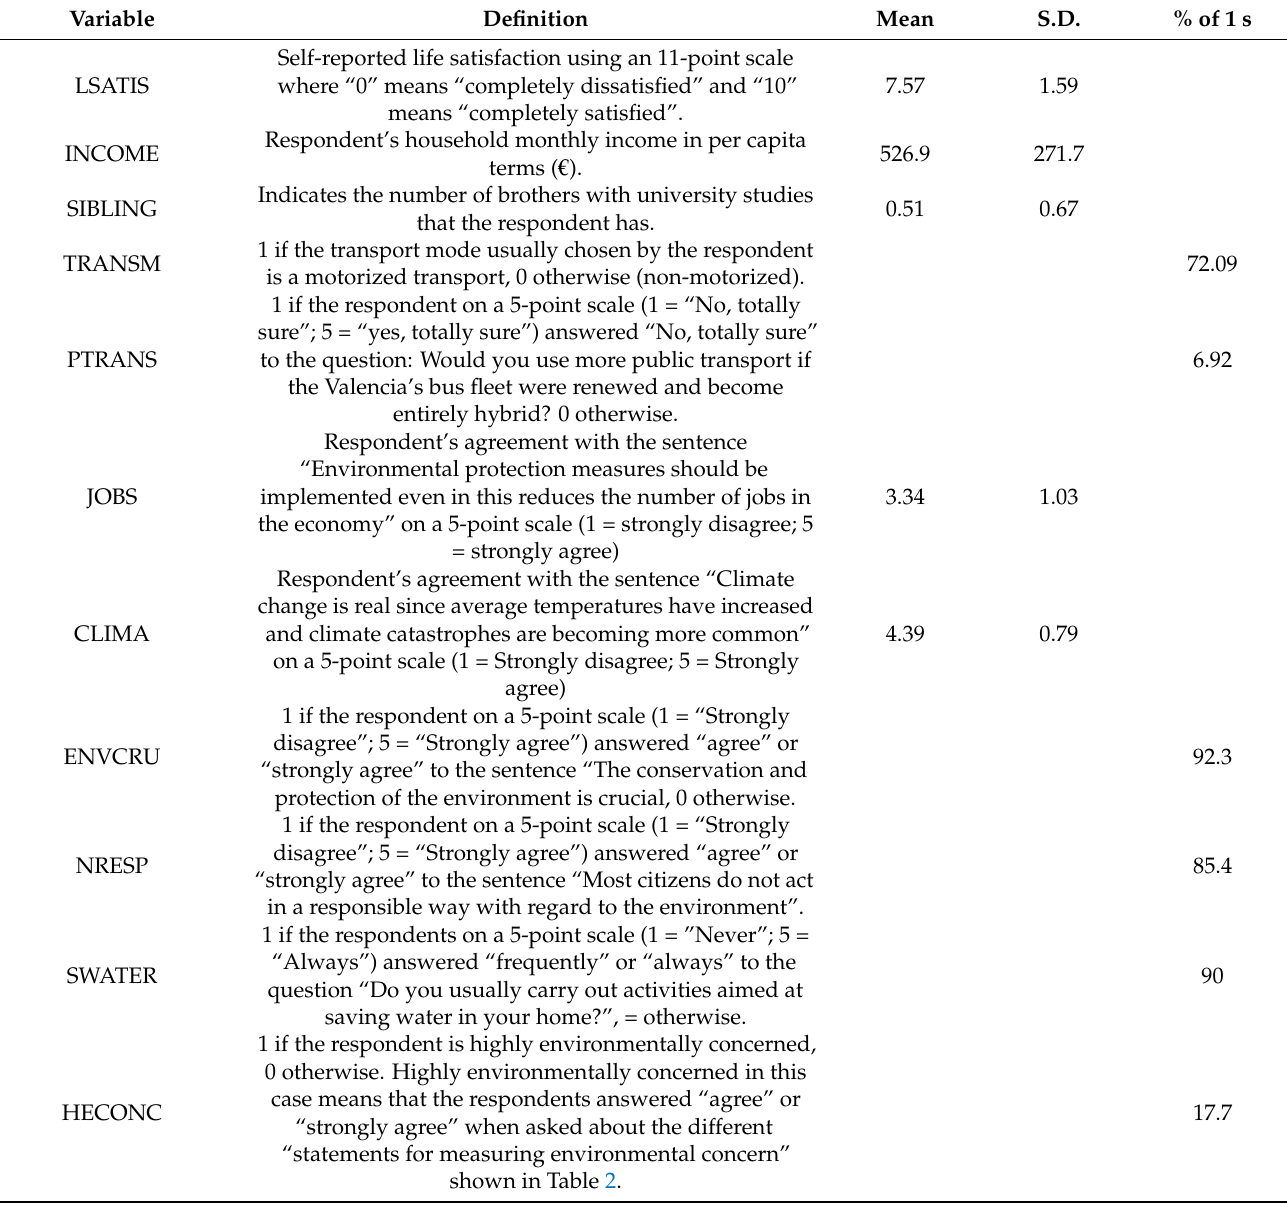
Table 2. Explanatory